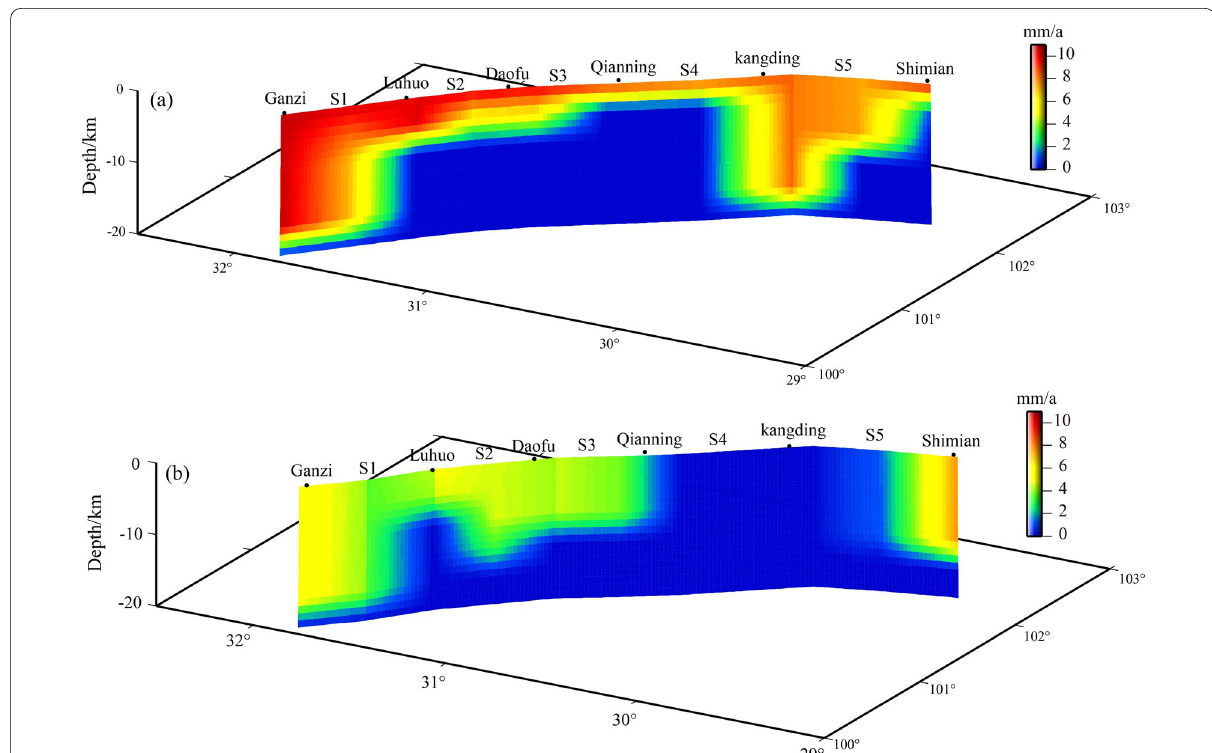
Fig. 9 Fault-parallel slip-rate deficit in the Xianshuihe Fault Zone. a and b The fault-parallel slip-rate deficits in 1999–2007 and 2016–2020. S1–S5 represent the Luhuo, Daofu, Qianning, Kangding, and Moxi sections,